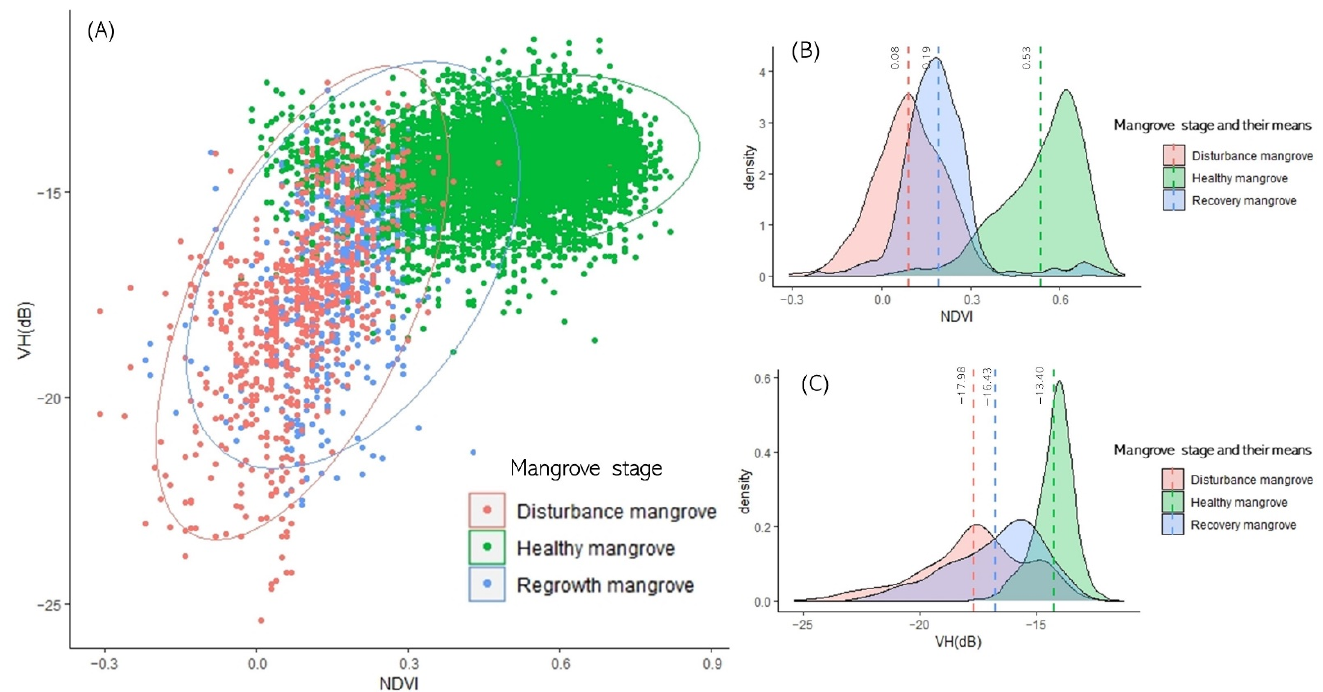
Figure 12. Clusters and Density Scatter Plotting of Mangroves in Different Stages Using the Correlation of NDVI and VH from Multiple-Incidence Angles. ( A ) The correlation between NDVI and VH backscatter from multiple-incidence angles illustrating the cluster of each mangrove stage. ( B ) The density scatter plot of NDVI for each mangrove stage. ( C ) The density scatter plot of VH for each mangrove stage.